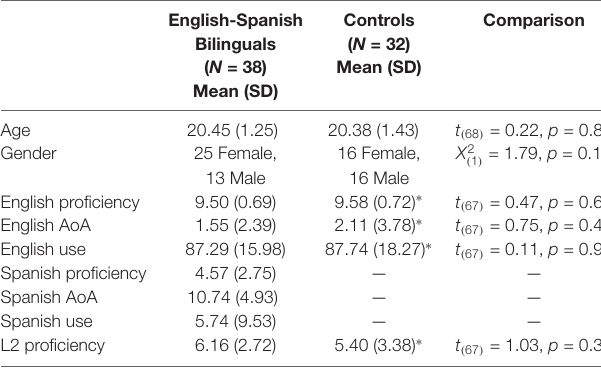
TABLE 1 | Participant demographic